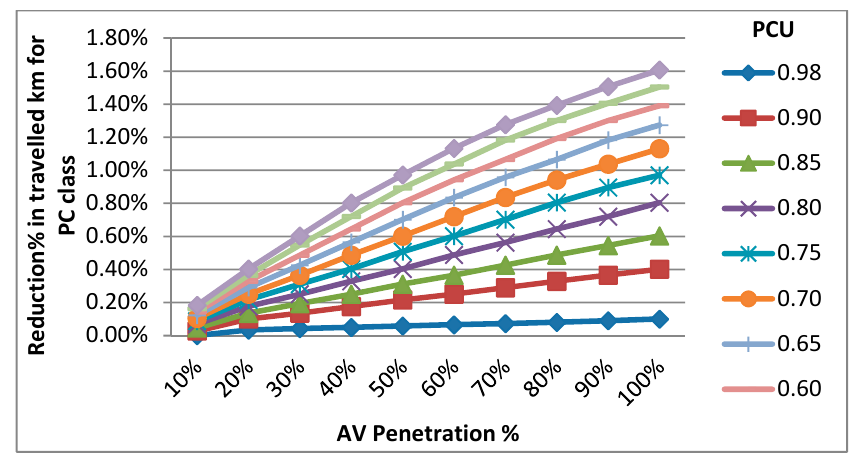
Figure 3. Reduction percent in traveled kilometers for passenger car class.